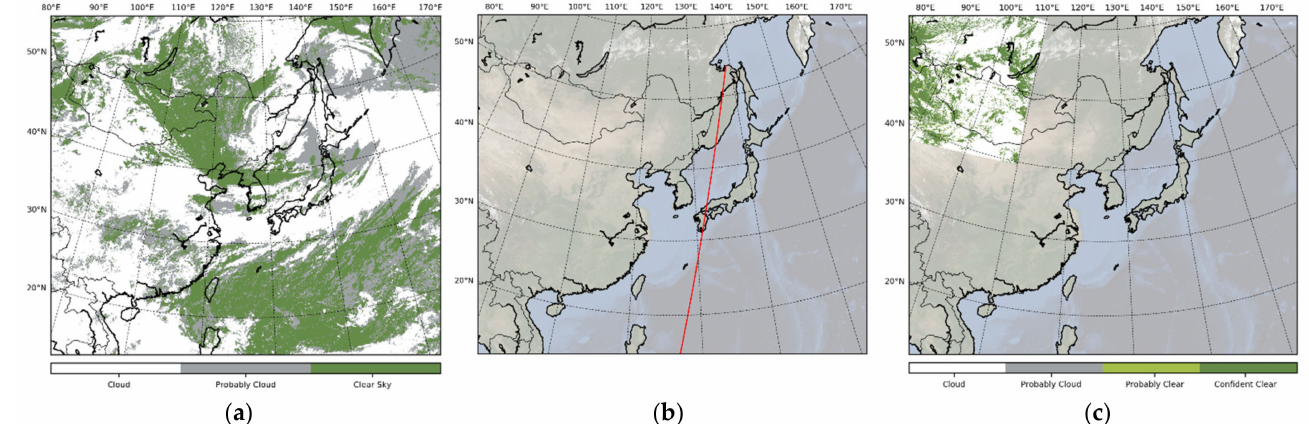
Figure 2. Example of comparison and validation dataset: ( a ) GK-2A cloud mask acquired from 15 June 2020 03:00 UTC, ( b ) CALIPSO cloud product acquired from 15 June 2020 05:40 UTC. The red line in the image denotes path of CALIPSO data in specific time range, and ( c ) VIIRS cloud mask acquired from 15 June 2020 06:50